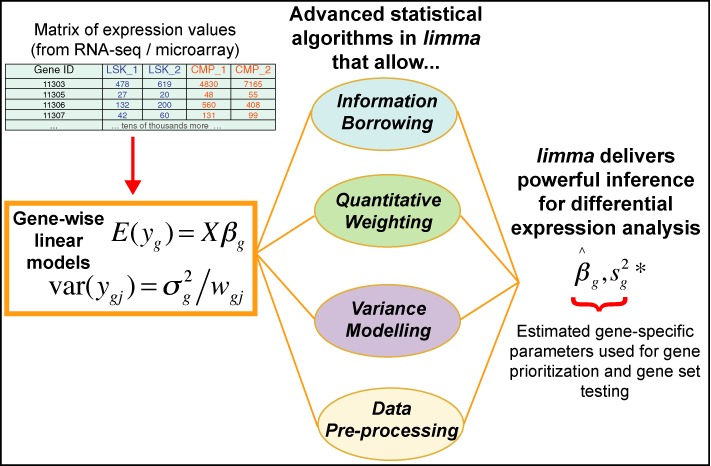
Schematic of the major components that are central to any limma analysis. For each gene g, we have a vector of gene expression values (yg) and a design matrix X that relates these values to some coefficients of interest (βg). The limma package includes statistical methods that (i) facilitate information borrowing using empirical Bayes methods to obtain posterior variance estimators (\documentclass[12pt]{minimal}
\usepackage{amsmath}
\usepackage{wasysym}
\usepackage{amsfonts}
\usepackage{amssymb}
\usepackage{amsbsy}
\usepackage{upgreek}
\usepackage{mathrsfs}
\setlength{\oddsidemargin}{-69pt}
\begin{document}
}{}$s^{2*}_g$\end{document}), (ii) incorporate observation weights (wgj where j refers to sample) to allow for variations in data quality, (iii) allow variance modelling to accommodate technical or biological heterogeneity that may be present and (iv) pre-processing methods such as variance stabilization to reduce noise. These methods all help improve inference at both the gene and gene set level in small experiments.